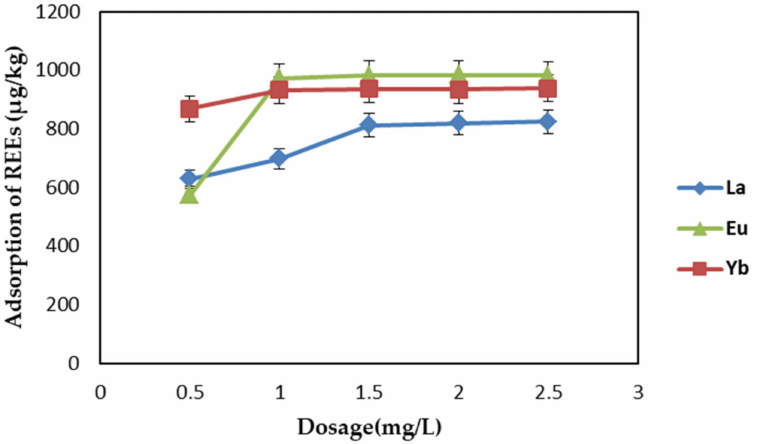
Figure 4. Effect of adsorbent dosage on adsorption of rare-earth elements (REEs) by